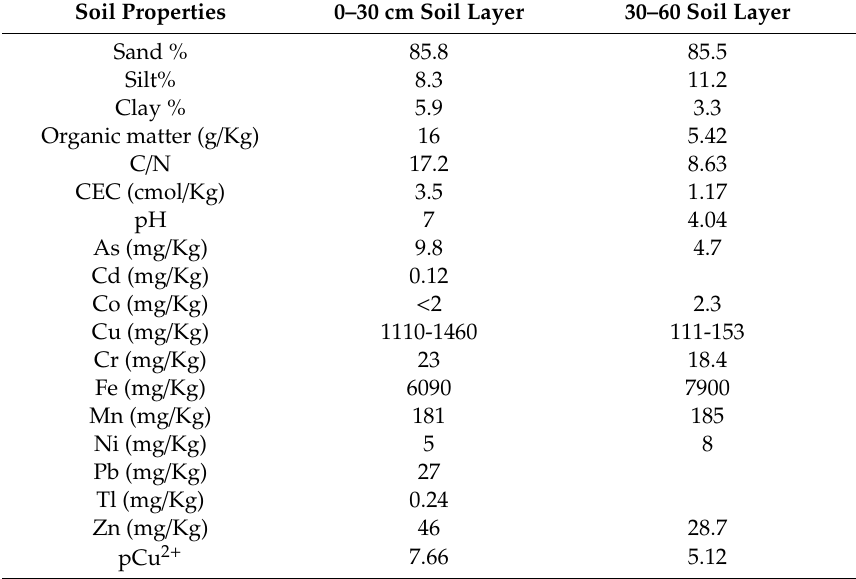
Table A1. Main properties of the soil layers used to fill the lysimeters and main soil characteristics